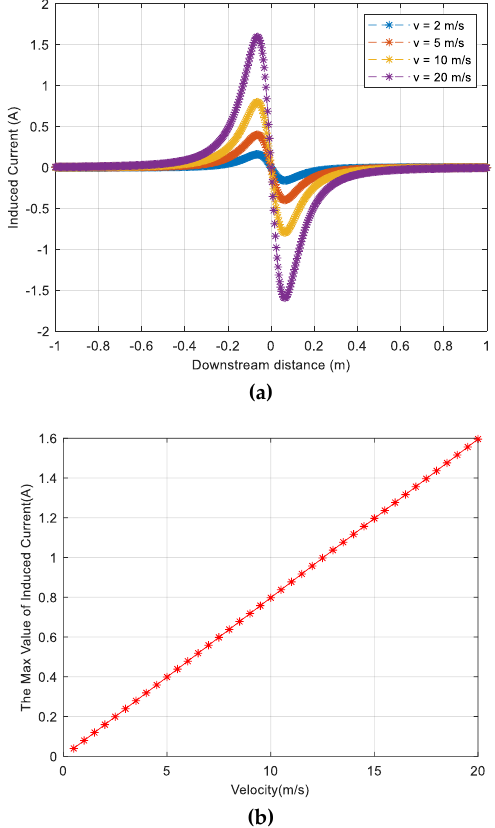
Figure 15. ( a ) Induced current under the effect of the point charge moving at different velocities, and ( b ) variation of the maximum induced current with the velocity change.